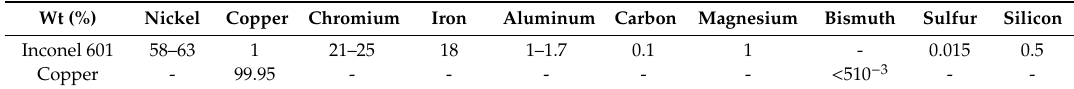
Table 1. Chemical compositions of materials.